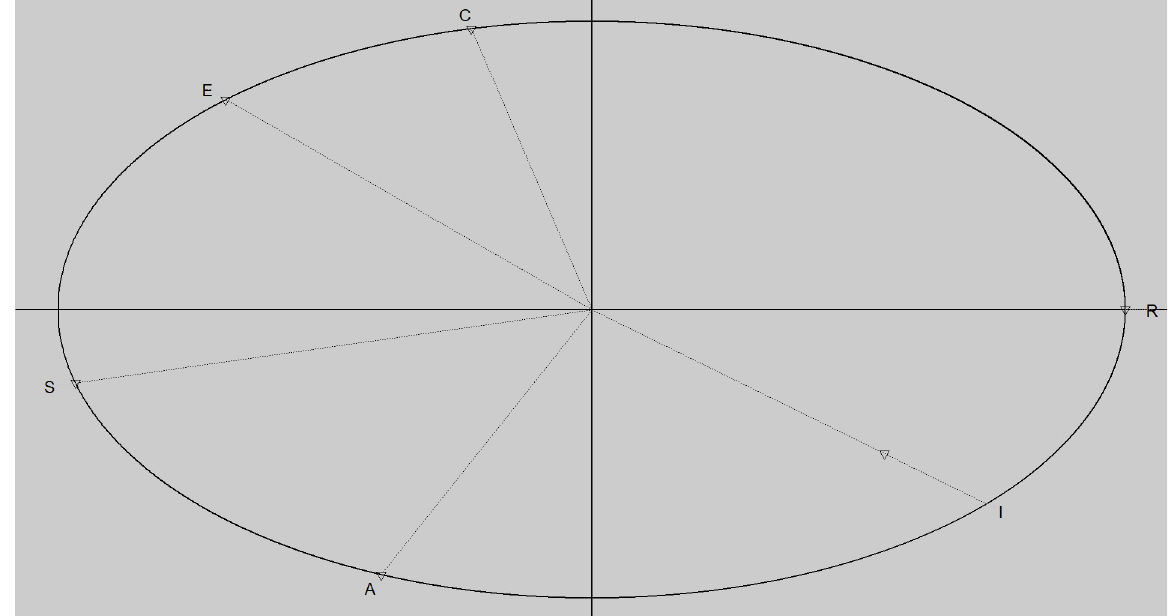
Fig 1. Verified study specific circumplex structure of the RIASEC model. R = realistic dimension, I = investigative dimension, A = artistic dimension, S = social dimension, E = enterprising dimension, C = conventional dimension.